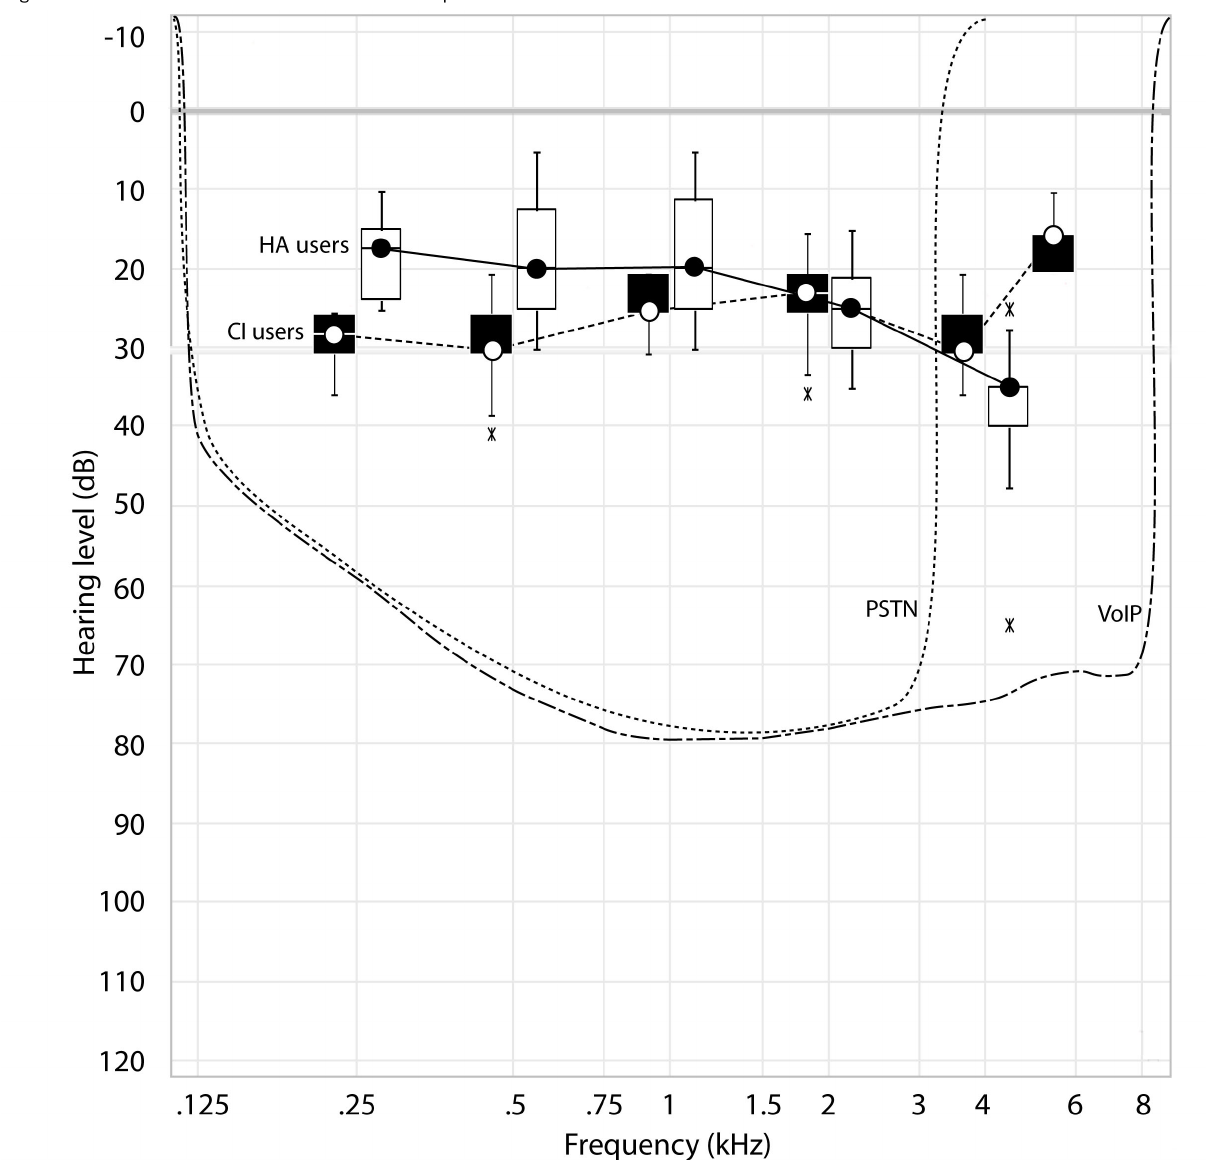
Figure 2. Lower quartile, median, upper quartile, and 1.5*interquartile range (X = outliers) of aided hearing thresholds in the free sound field for cochlear implant (CI) and hearing aid (HA) users. The analog telephone (public switched telephone network [PSTN]) speech signals are shown in dB hearing level as dotted lines. VoIP = voice over Internet